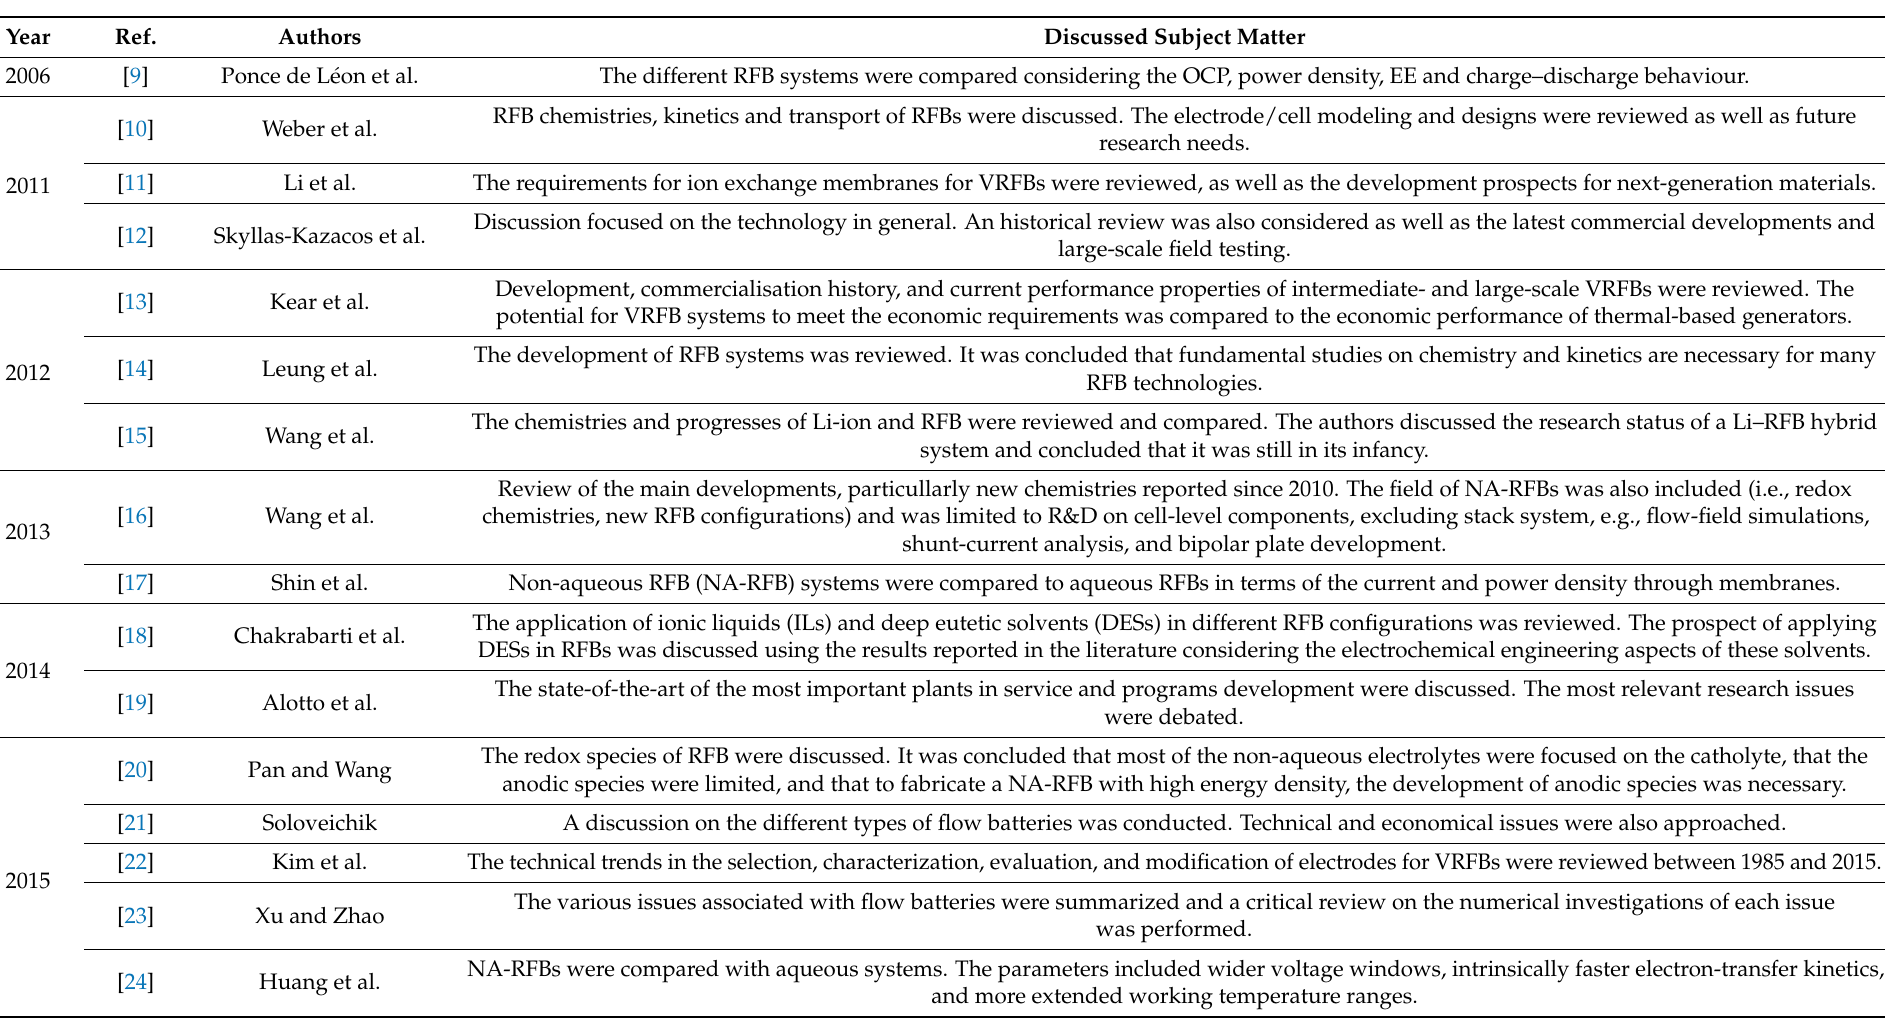
Table 1. The main review articles about RFBs published in the last few